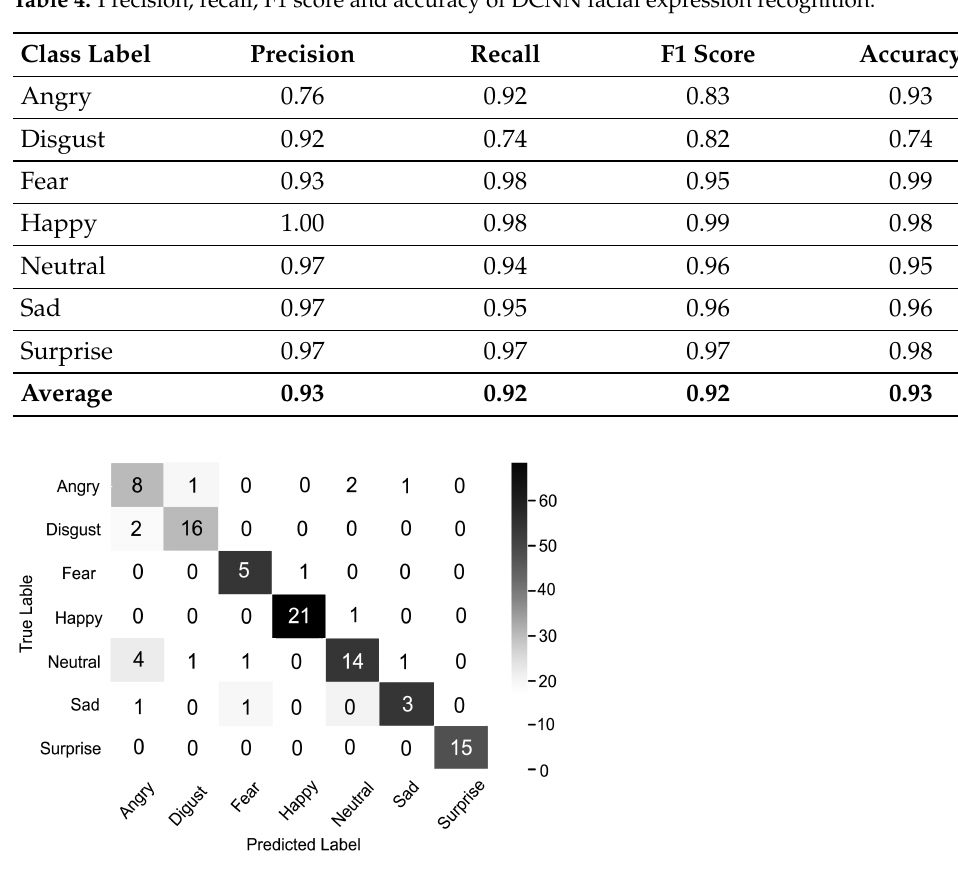
Table 4. Precision, recall, F1 score and accuracy of DCNN facial expression recognition.